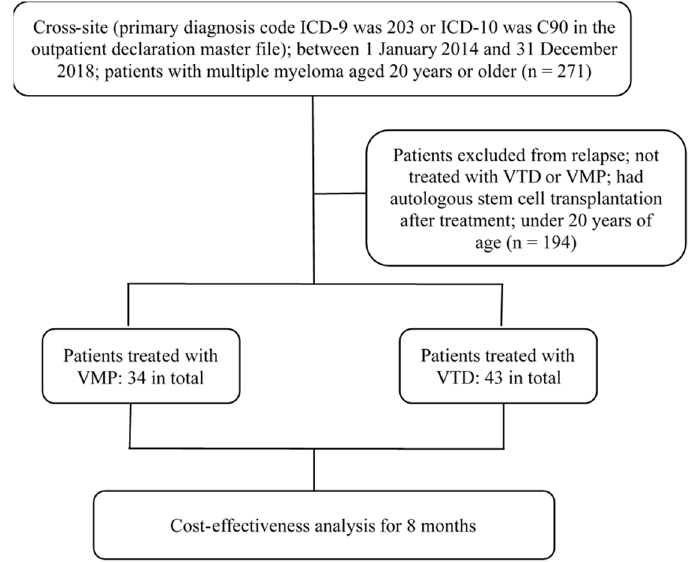
Figure 1. The flow chart of patient